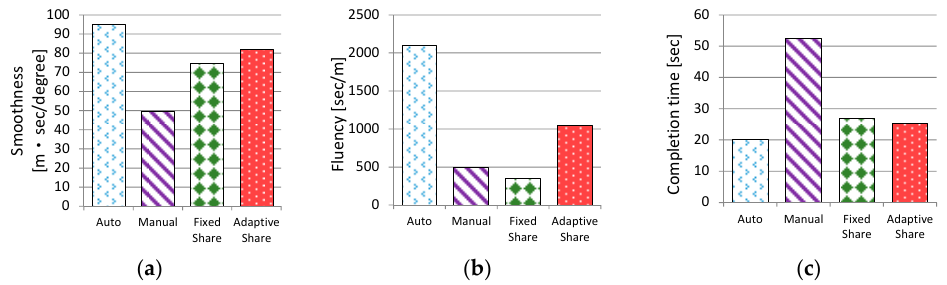
Figure 16. Experimental results of over-speeding control with skill-based error using four control modes in terms of the three criteria. ( a ) Smoothness ( b ) Fluency, ( c ) Completion time.